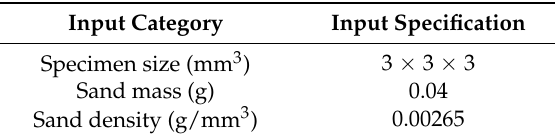
Table 4. Sieve distribution of the mortar-s scale.